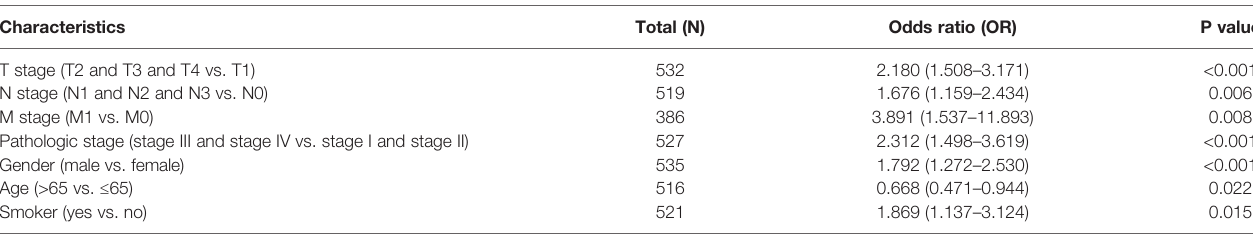
TABLE 2 | Logistic regression analyzed the correlation between SGO1 expression and clinical pathological characteristics in LUAD. Characteristics Total (N) Odds ratio (OR) P value T stage (T2 and T3 and T4 vs.